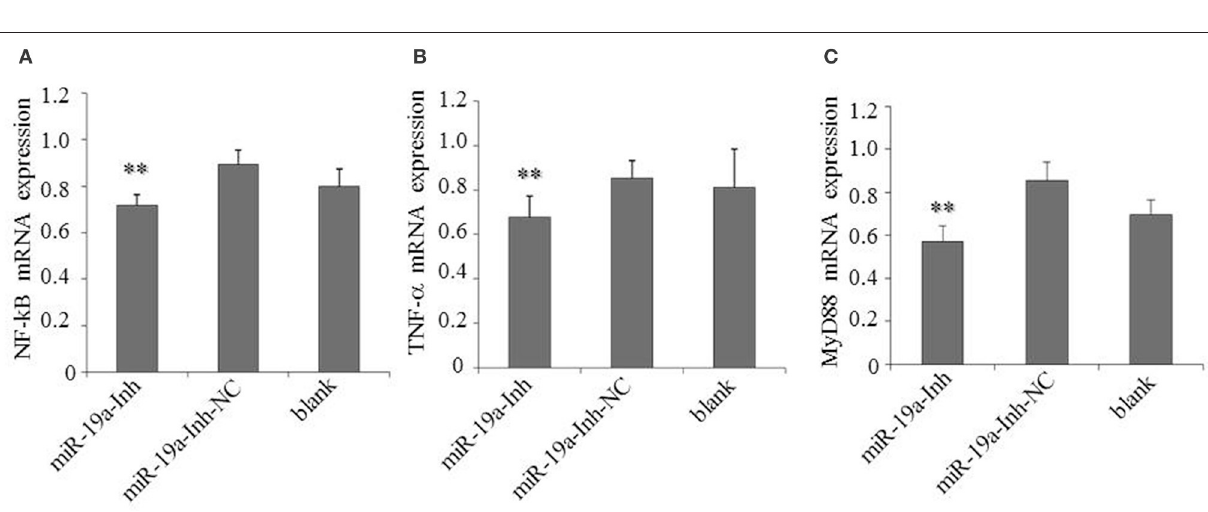
FIGURE 11 | Inhibition of gga-miR-19a reduces NF- κ B, TNF- α and MyD88 expression. DF-1 cells were transfected with miR-19a -Inh or the negative control. At 48 h post-transfection, the expression of NF- κ B (A) , TNF- α (B) and MyD88 (C) were measured by RT-qPCR. A mock transfection was used as the blank, and the expression of GAPDH was used as a loading control. All values are represented as the mean ± SD of three independent experiments in triplicate. Significant differences are denoted as ** P <